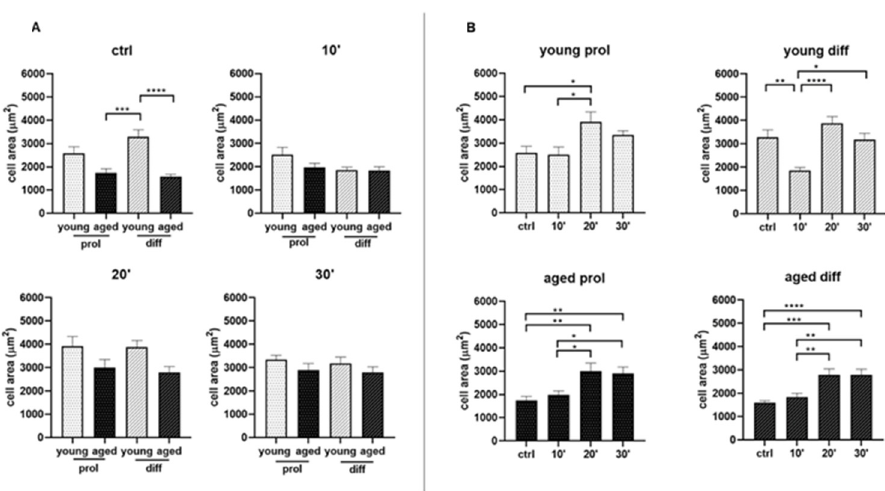
Figure 3. Effect of ViSS treatment on SC/myoblast area. ( A ) Comparison between young and aged samples in the same experimental conditions. ( B ) Control and treated samples of the same experimental group. Data from three different experiments are expressed as mean ± SEM. A total of 16–22 cells for each group per experiment were analyzed. Significance was determined with ordinary one-way ANOVA test, followed by Tukey’s multiple comparisons test. * p ≤ 0.05, ** p ≤ 0.005, *** p ≤ 0.001, **** p ≤ 0.0001.